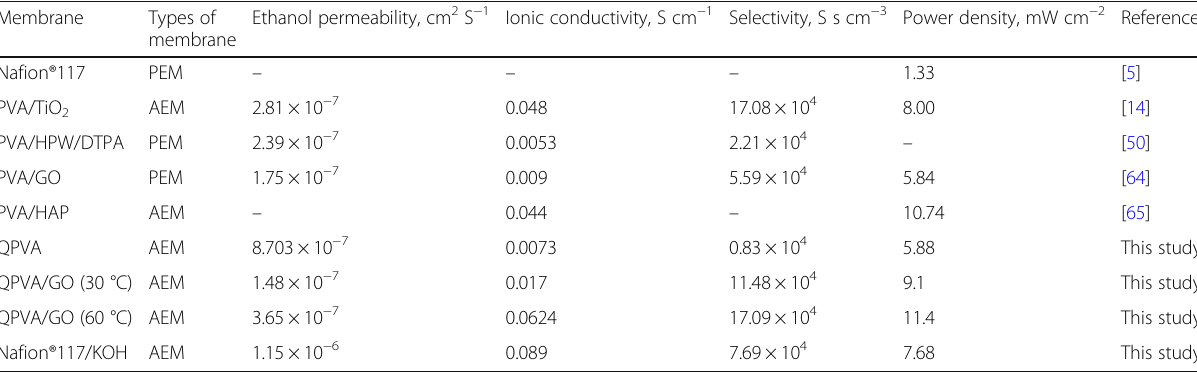
Table 3 Comparison of ethanol permeability, ionic conductivity, and selectivity factor for the PVA-based membrane in passive DEFC Membrane